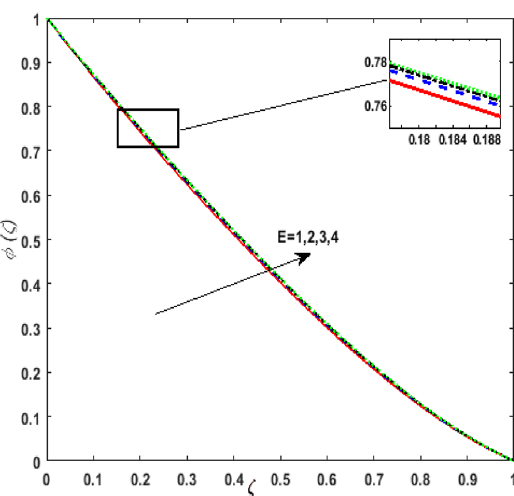
Figure 17. Effect of activation energy E on concentration φ(ζ) .